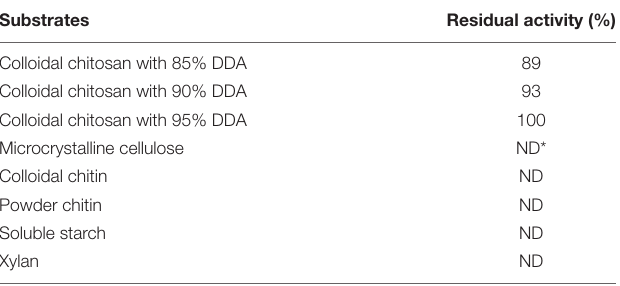
TABLE 2 | The substrate specificity of Sh Csn46.